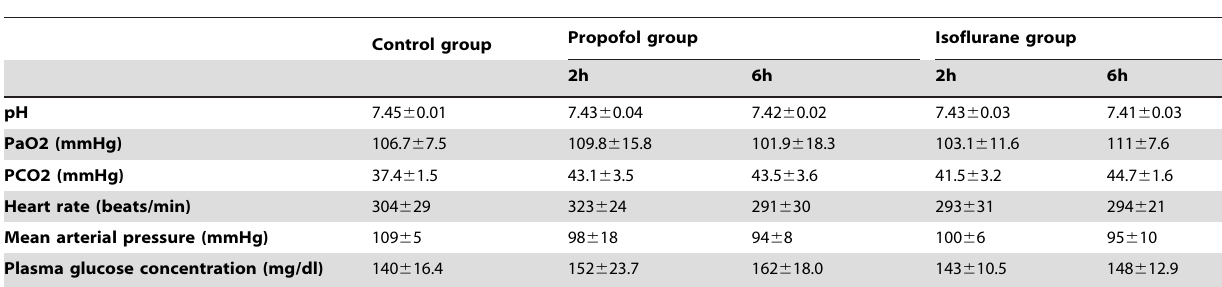
Table 1. Physiological Parameters in Control and Anesthetized Rats.